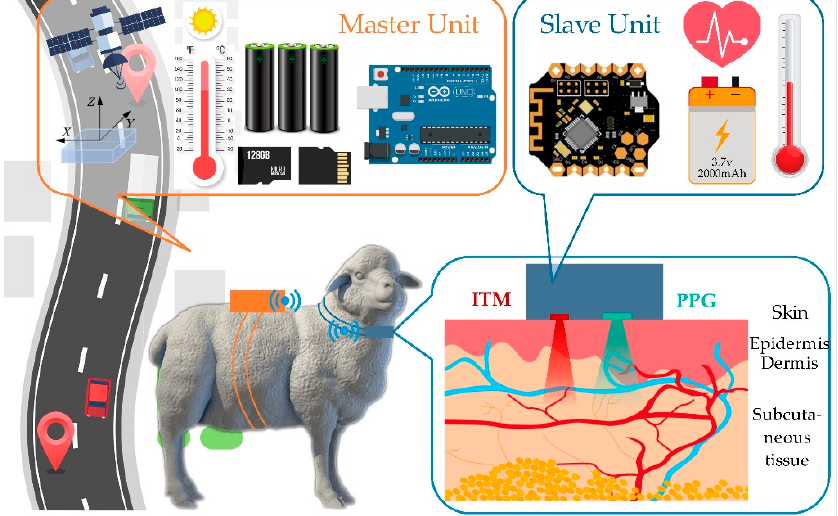
Figure 1. The Wearable Stress Monitoring System (WSMS) architecture based on multi-sensor platform. Table 2. Basic information of sheep test samples (n=6).